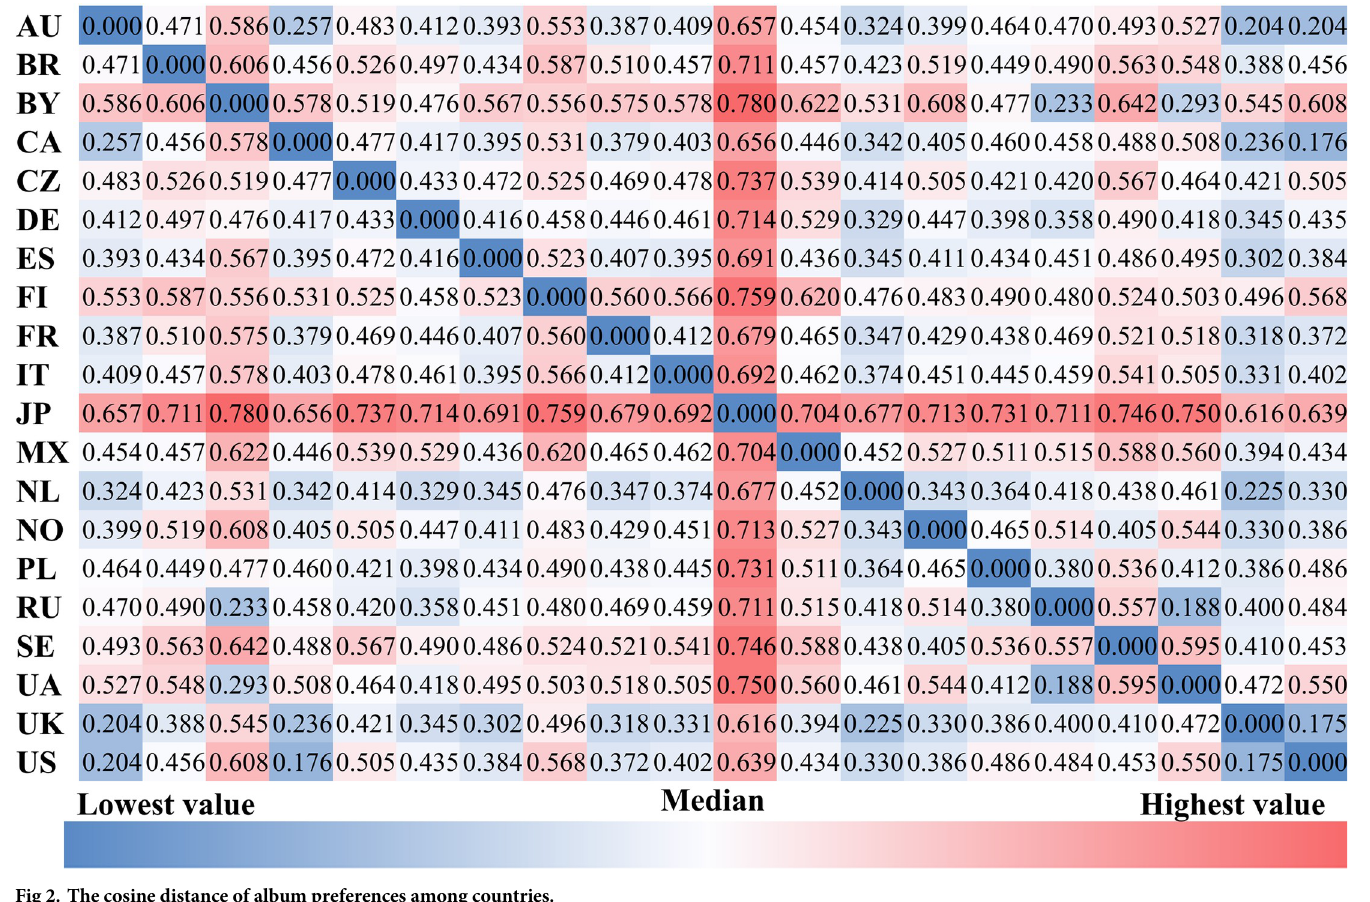
Fig 2. The cosine distance of album preferences among